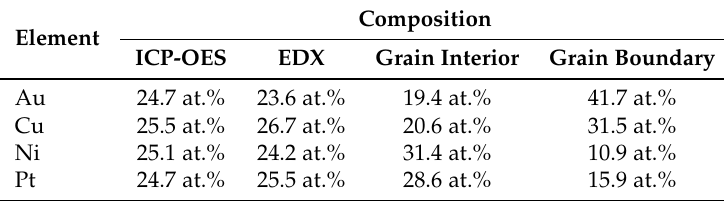
Table 2. Compositions of the sample as obtained on a large scale from ICP-OES measurements (left) as well as obtained locally from EDX analysis covering the whole area shown in Figure 5 and point analyses at the grain interior (dark regions in Figure 5) and the grain boundary (bright regions in Figure 5). The estimated standard deviation was 0.1 at.% for ICP-OES and 1 at.% for EDX, respectively.